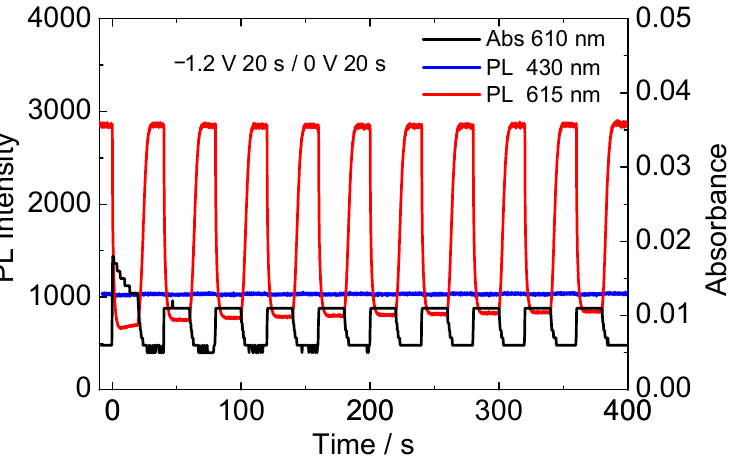
Figure 7. Repeated change in absorption (610 nm), and PL intensities of DPA (430 nm) and Eu(hfa) 3 (TPPO) 2 emissions (615 nm) of the electrofluorochromic device consisting of flat ITO elec- trode and ITO particle-modified electrode. Successive voltage for coloration and bleaching of the HV 2+ were applied to the device ( − 1.2 V/20 s and 0 V/20 s) repeatedly. Excitation wavelength was 333 nm.